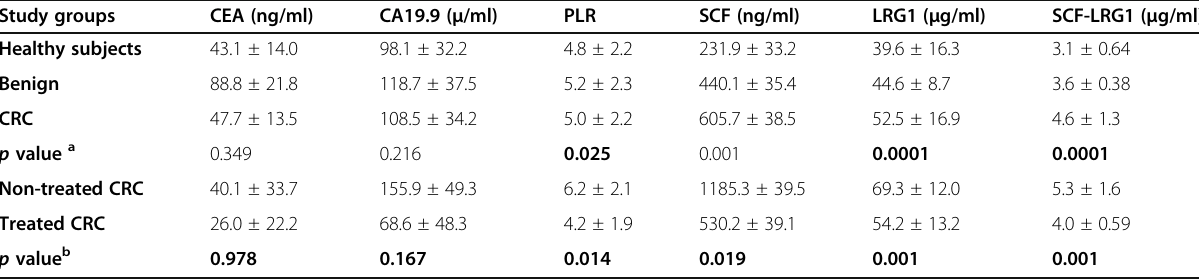
Table 2 Levels of traditional and candidate markers in studied groups Study groups